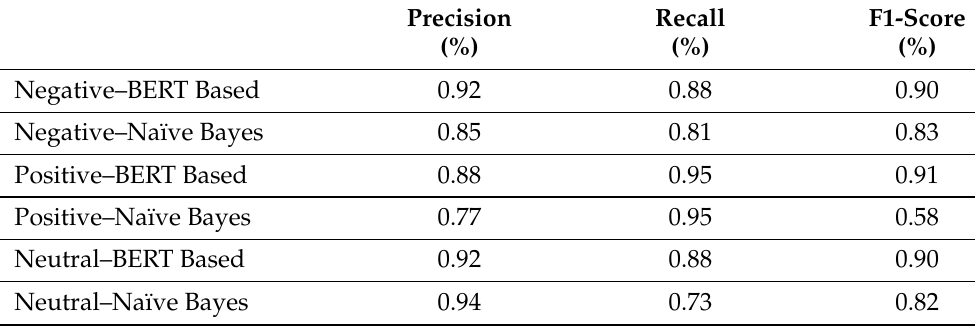
Table 4. Comparative Performance Test between BERT-based model and Naive Bayes